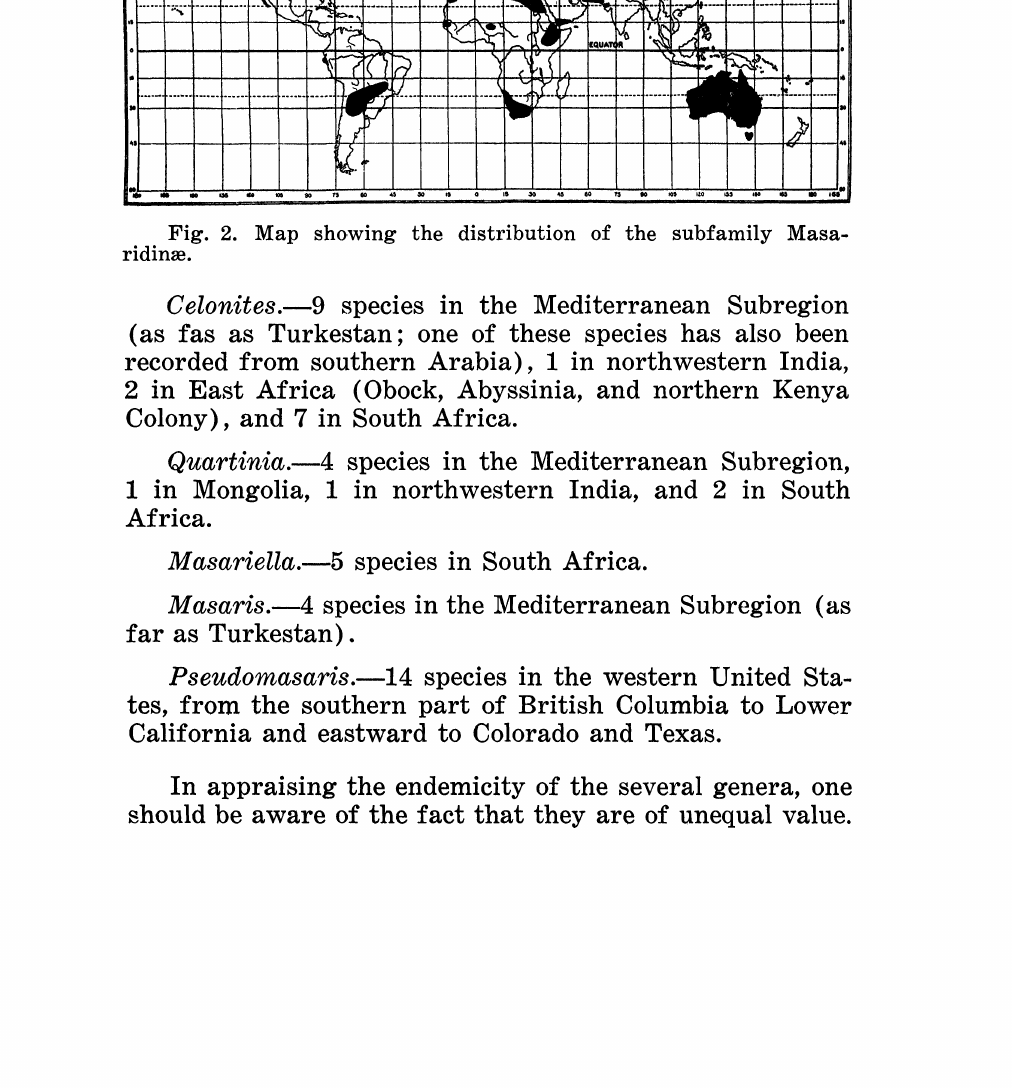
Fig. 2. Map showing the distribution of the subfamily Masa-